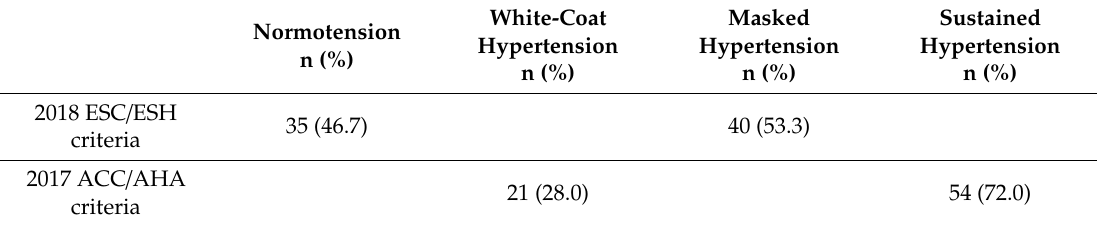
Table 4. Prevalence of hypertension phenotypes in participants with a systolic blood pressure of 130–139 mmHg and / or diastolic blood pressure of 80–89 mmHg. White-Coat